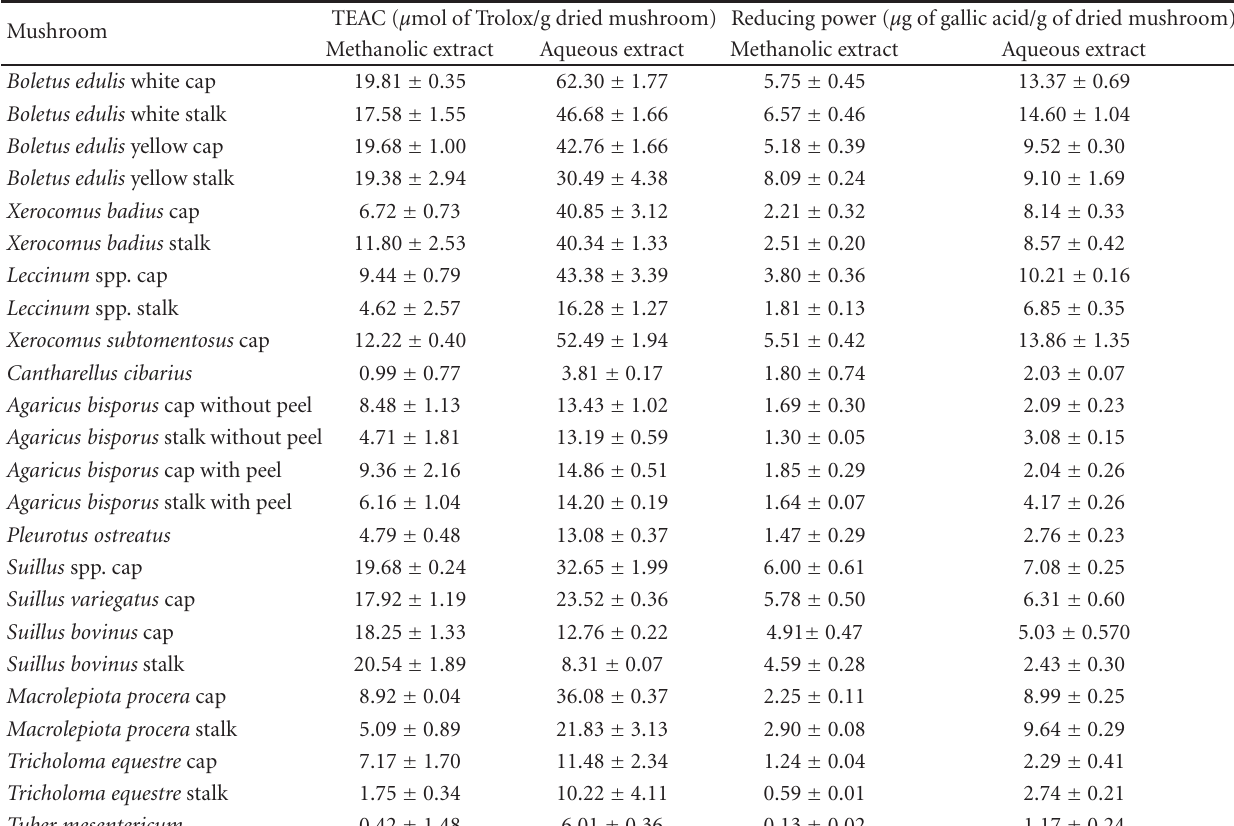
Table 3: Trolox equivalent anitoxidant capacity ( μ mol of Trolox/g dried mushroom) and reducing power ( μ g of gallic acid/g of dried mushroom) of edible Polish